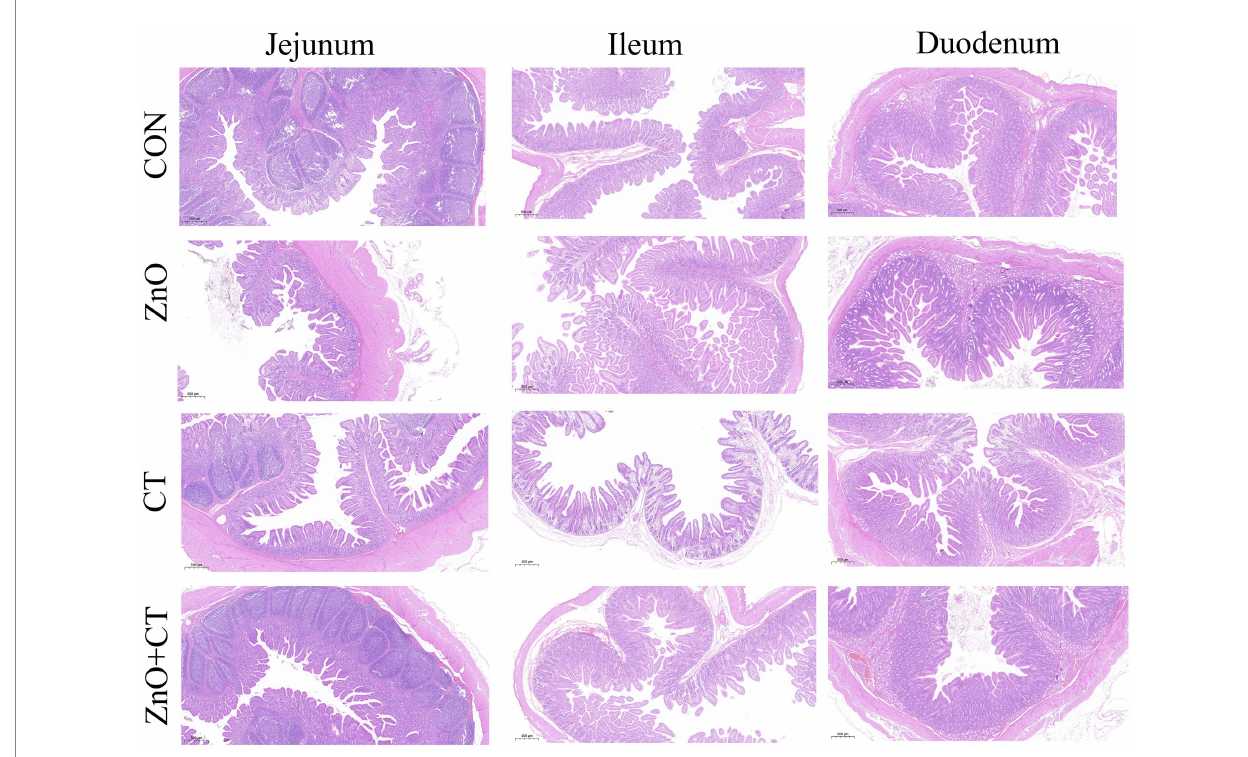
FIGURE 3 Effects of ZnO and CT on intestinal morphology of weaned piglets in K88-challenged environment.